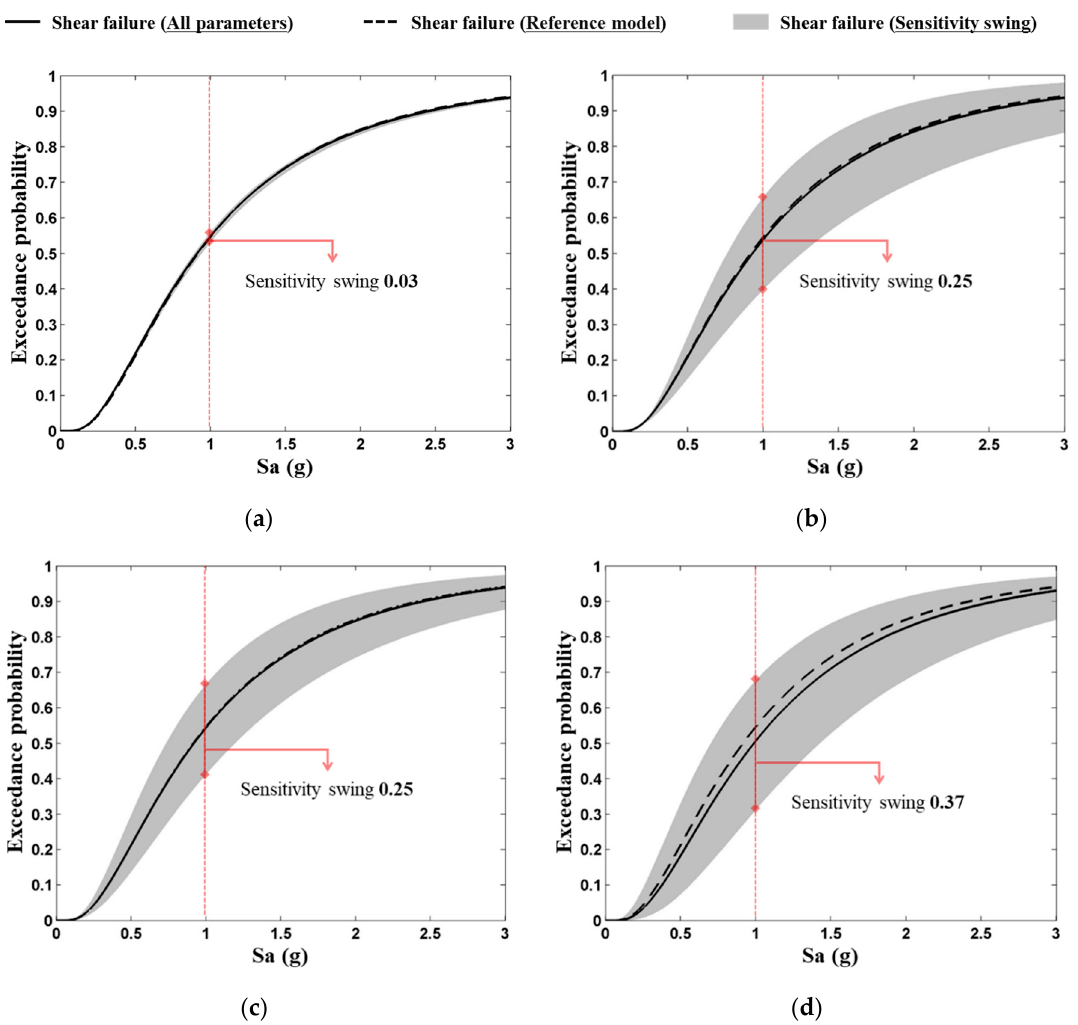
Figure 10. Sensitivity swing for shear vulnerability curves: ( a ) concrete strength; ( b ) yield strength; ( c ) longitudinal reinforcement ratio; ( d ) volumetric ratio of transverse reinforcement.